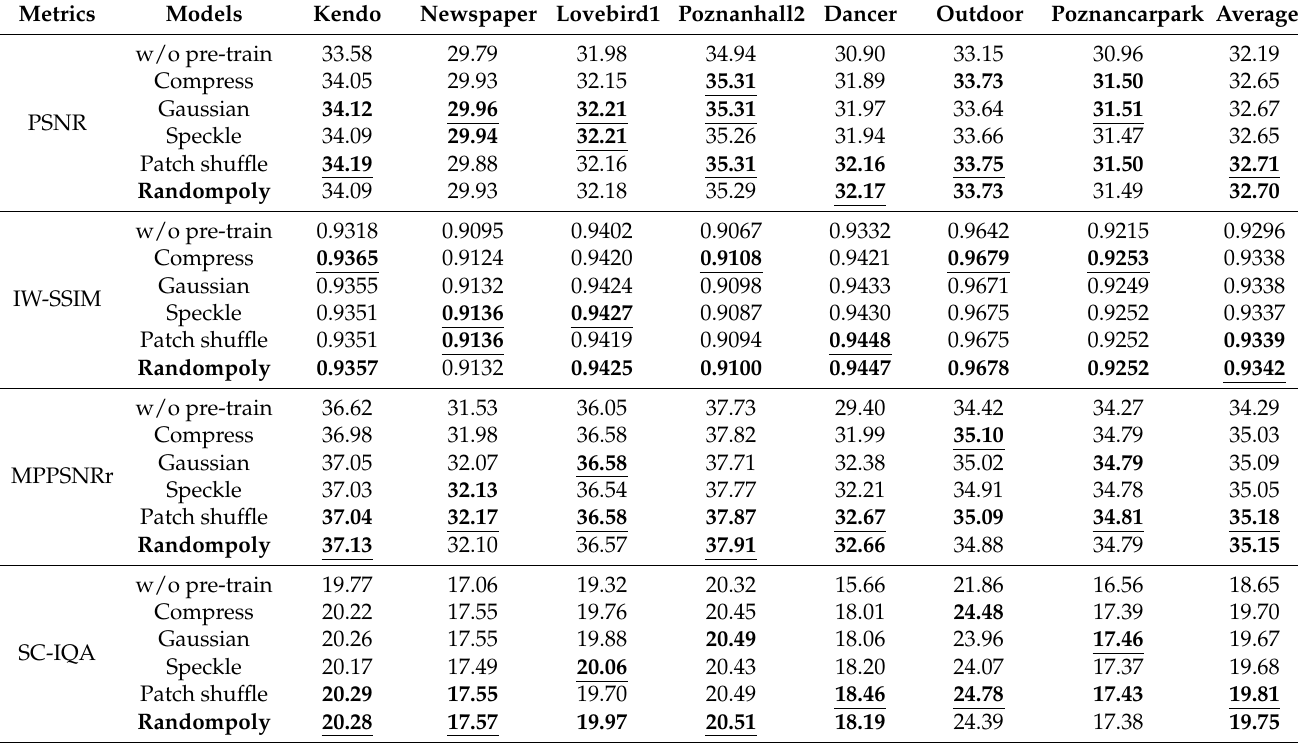
Table 4. SVQE performance comparison of DnCNN on Sess-H.264 by pre-training on synthetic synthesized image database with different random noise types generated from NYU database. ‘Randompoly’ is the proposed DIBR distortion simulation method and highlighted. The best and second results are highlighted in bold and the best results are underlined